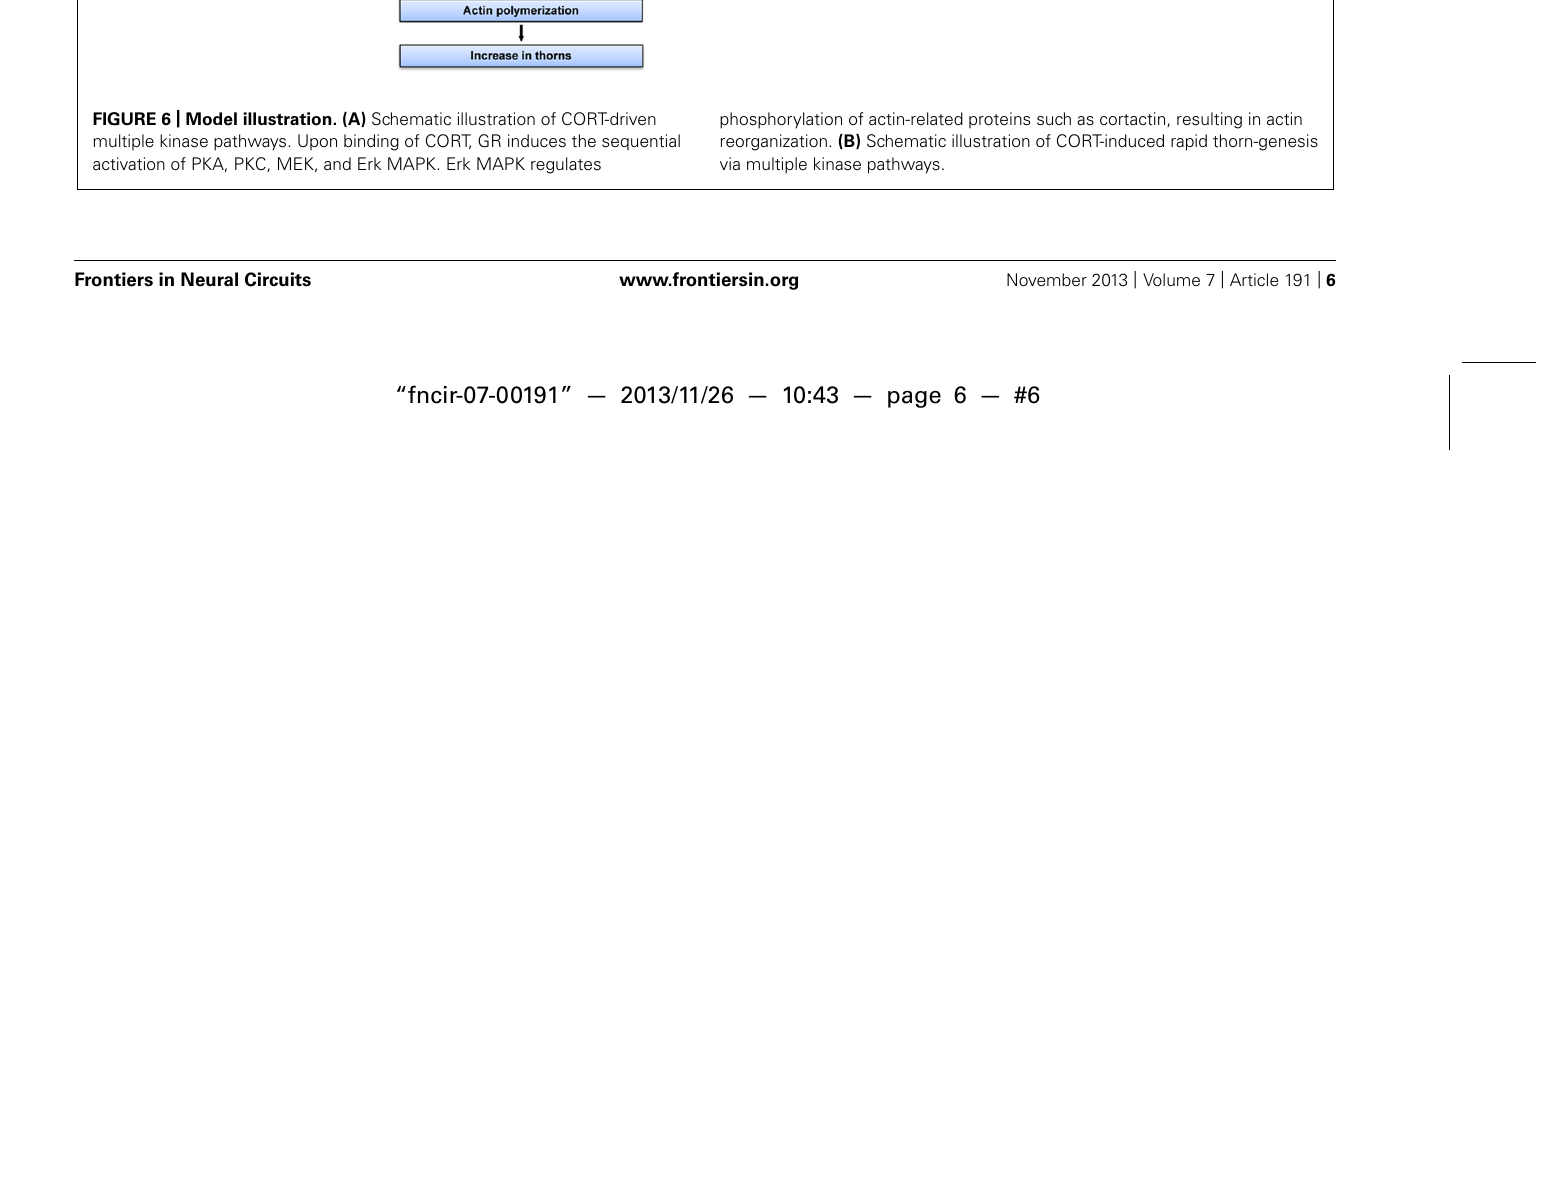
FIGURE 6 | Model illustration. (A) Schematic illustration of CORT-driven multiple kinase pathways. Upon binding of CORT, GR induces the sequential activation of PKA, PKC, MEK, and Erk MAPK. Erk MAPK regulates